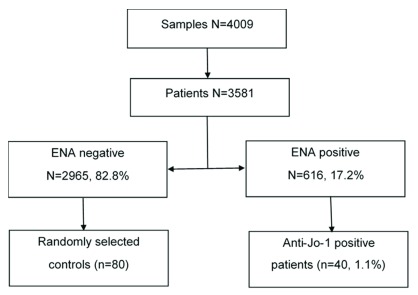
Study flow diagram.